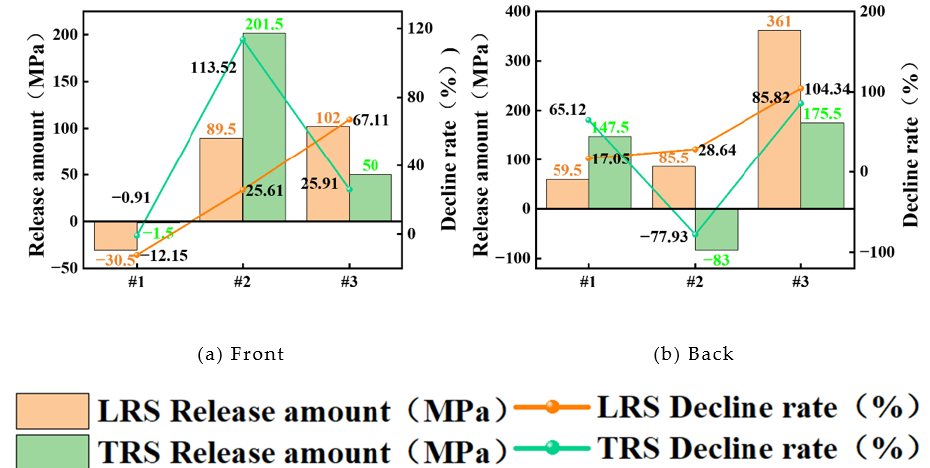
Figure 8. Change in average peak residual stress after treatment. ( a ) Front; ( b ) Back Table 6. Peak residual stress changes on the front side of samples #1, #2, and #3.